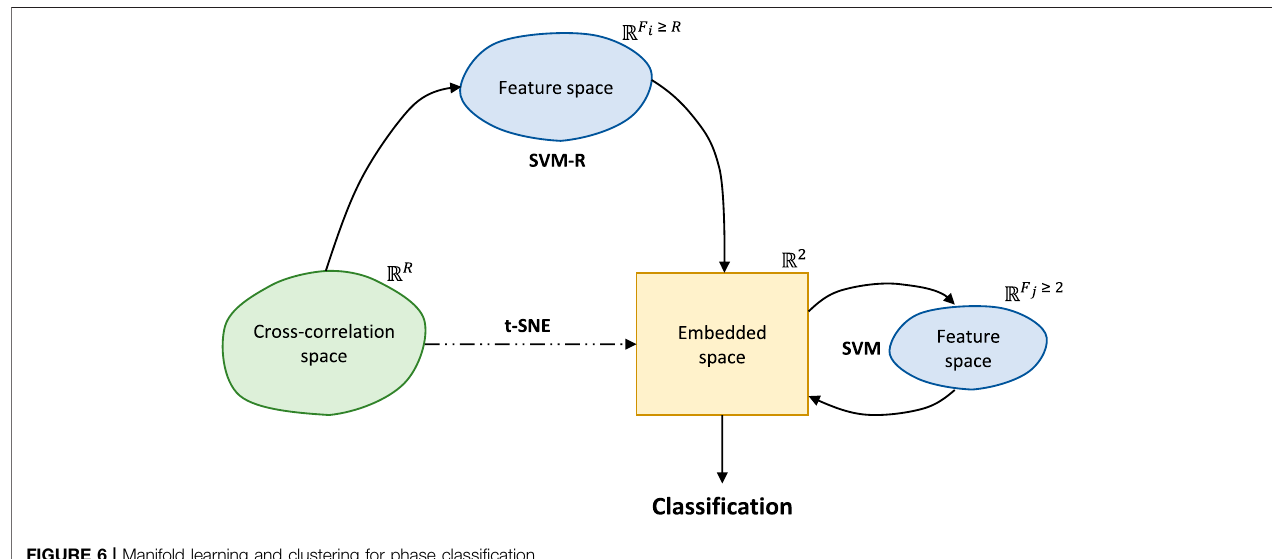
FIGURE 6 | Manifold learning and clustering for phase classi fi cation.